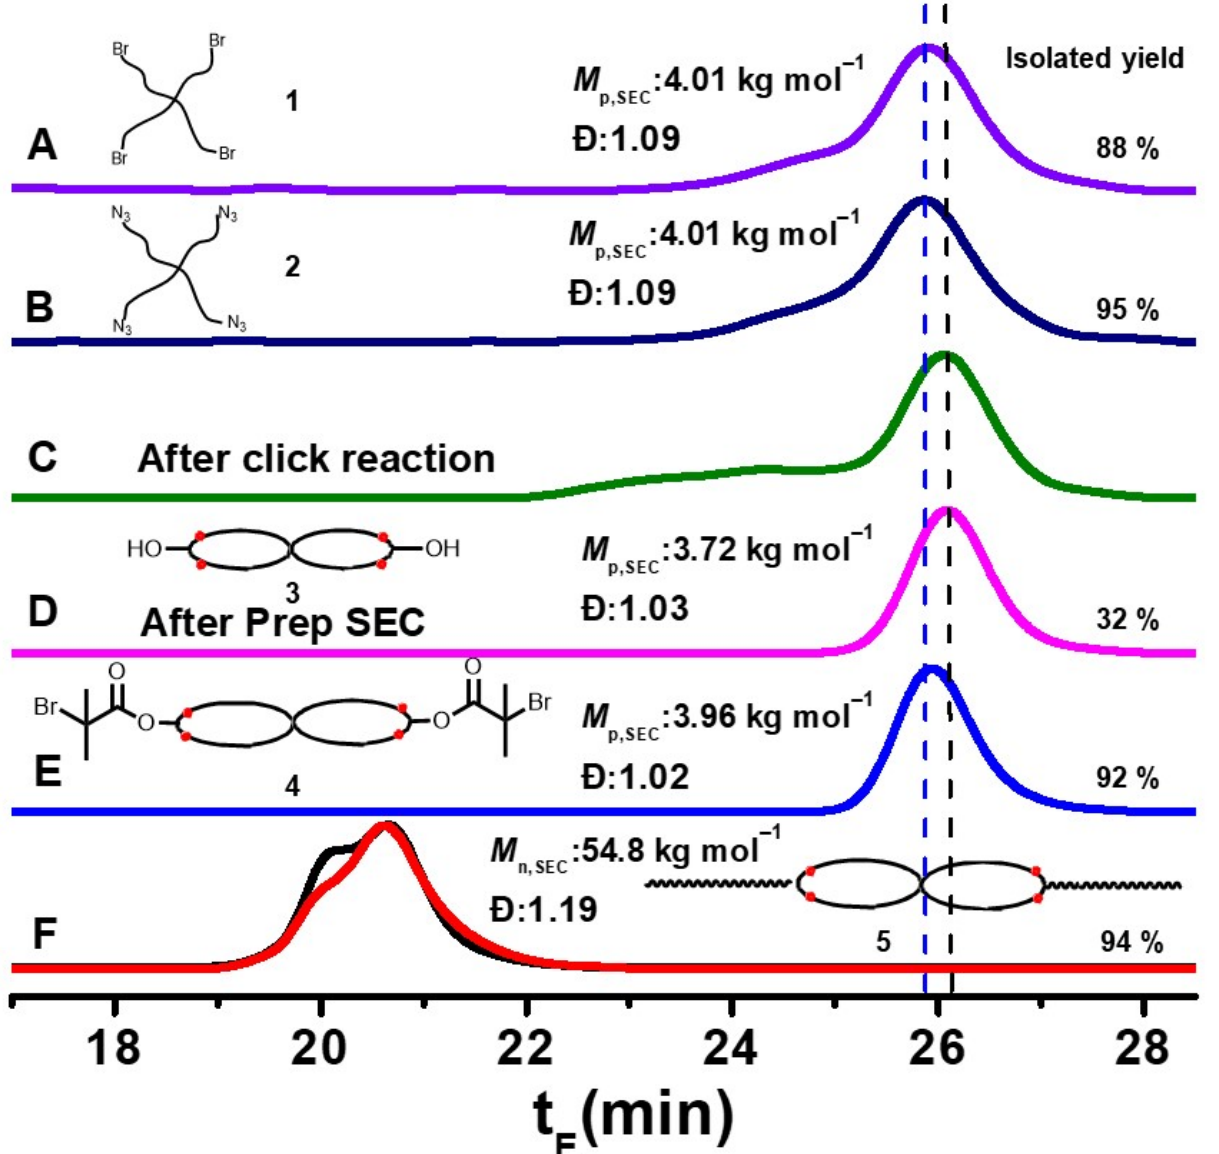
Figure 1. Comparison of the molecular weight with respect to elution time in the SEC measurements (all recorded using RI detector except red line (UV detector)). ( A ) Tetra-arm PS-Br, ( B ) tetra-arm PS-N 3 , ( C ) crude spirocyclic PS, ( D ) after prep SEC spirocyclic PS, ( E ) spirocyclic macroinitiator, and ( F ) PMMA- b -cPS- b -PMMA triblock copolymer.